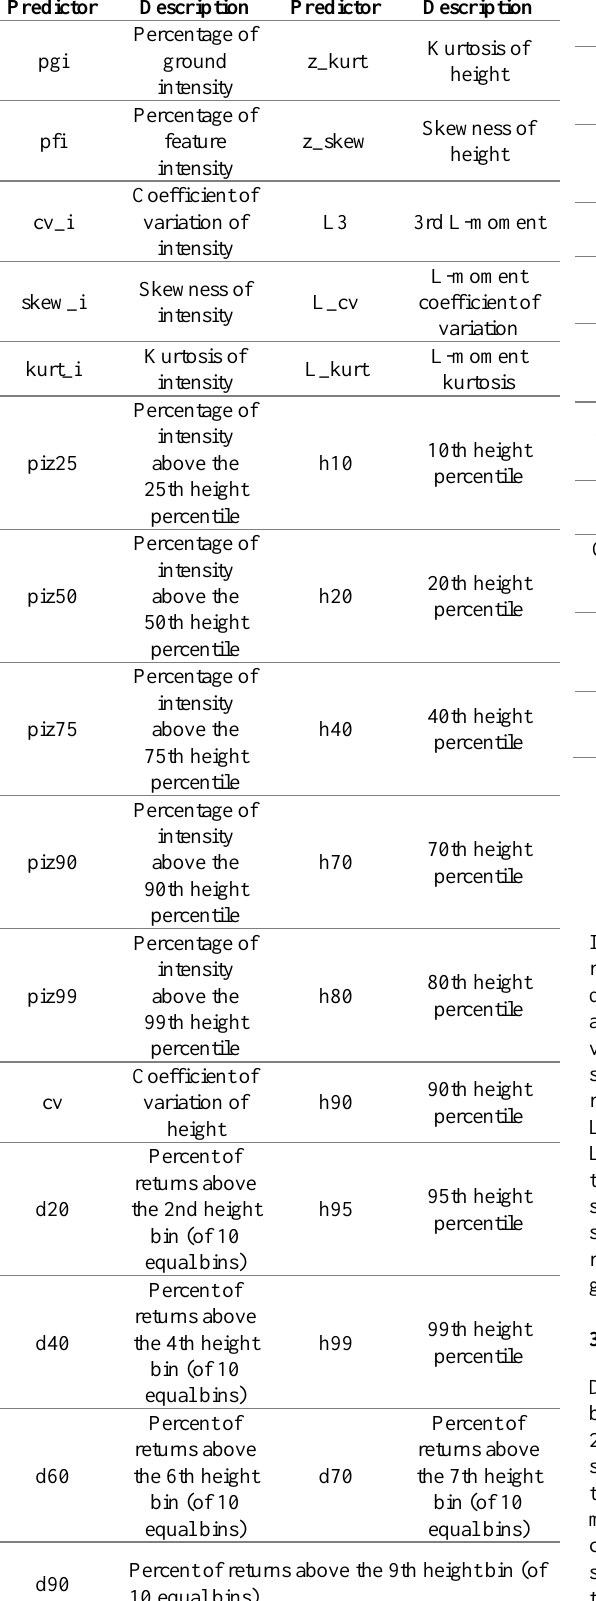
Table 1 . LiDAR predictors used to estimate AGB over Huntington Wildlife Forest.